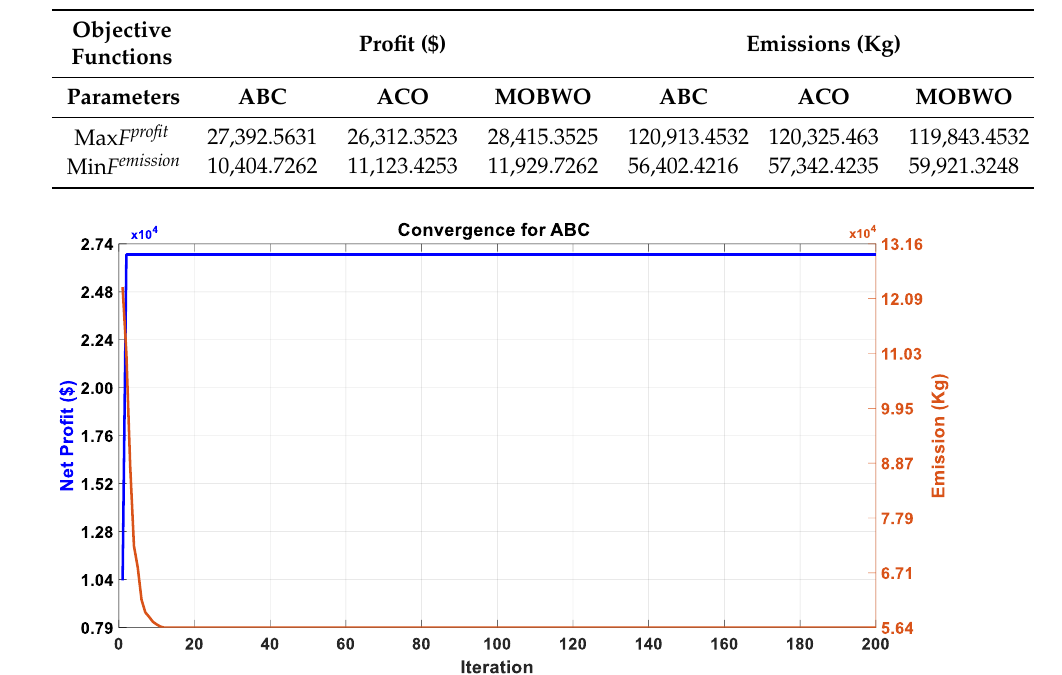
Figure 20. Convergence curve of the ABC algorithm.